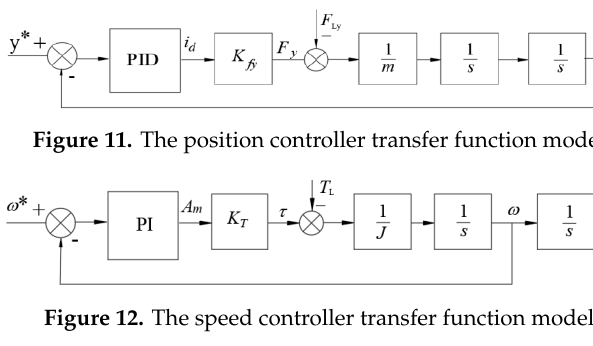
Figure 12. The speed controller transfer function model.